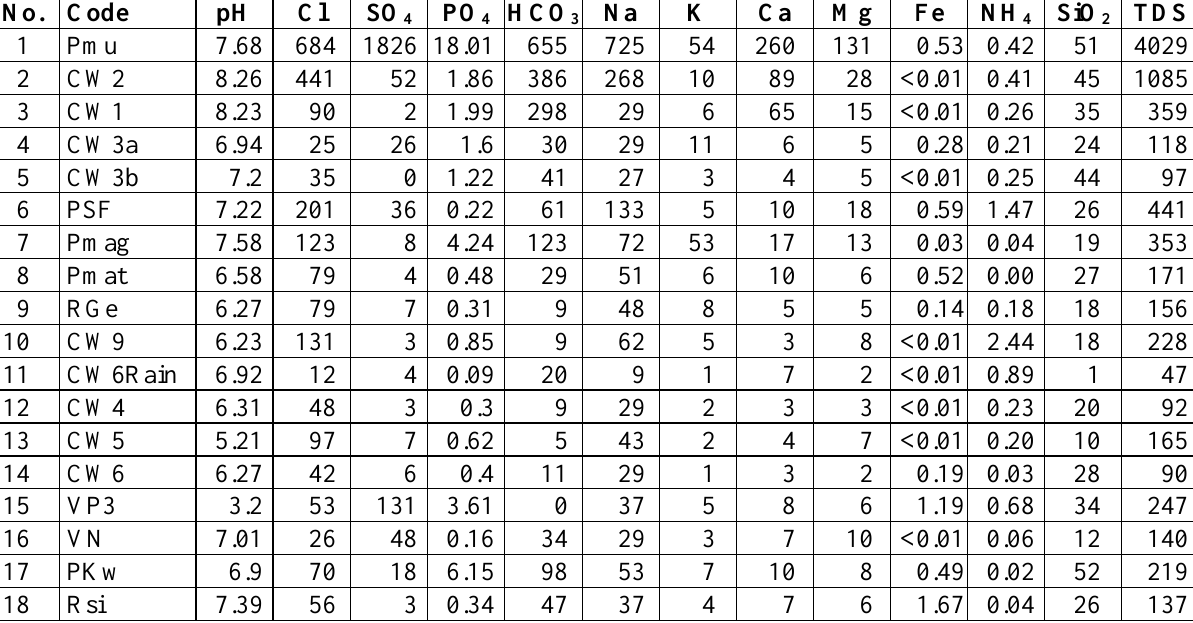
Table A3. Ionic composition of the water samples collected from the Maputaland Coastal Plain in October 2017. All the macro ions are reported in mg L -1